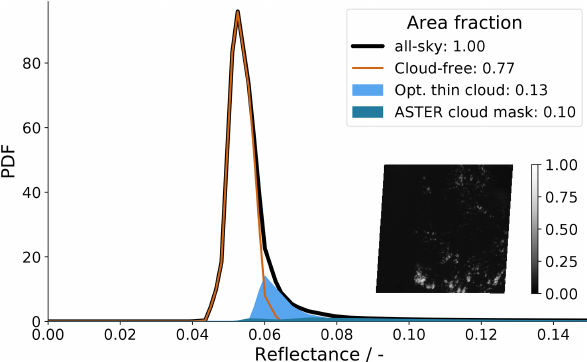
Figure 4. Reflectance distribution corresponding to the ASTER observation shown in the inset recorded on 31 January 2020 at 14:08:05UTC southeast of the HALO circle area at 11.37 ◦ N, 53.86 ◦ W. The cloud-free contribution is retrieved with the method (1) described in Sect. 3.2 and displayed by the orange curve, while pixel reflectances identified as cloudy from the ASTER cloud- masking algorithm are shown in dark blue. We attribute the light blue contribution to the distribution to optically thin